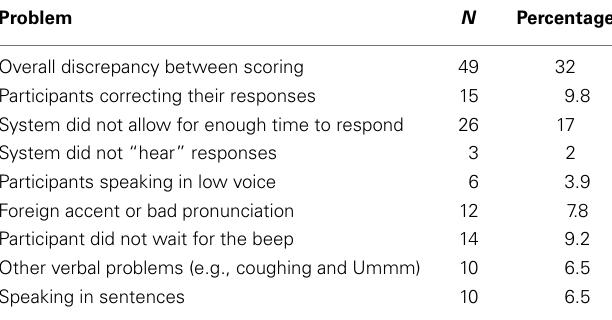
Table 6 | Issues causing verbal recognition problems by the system (Digit Span Backward task).